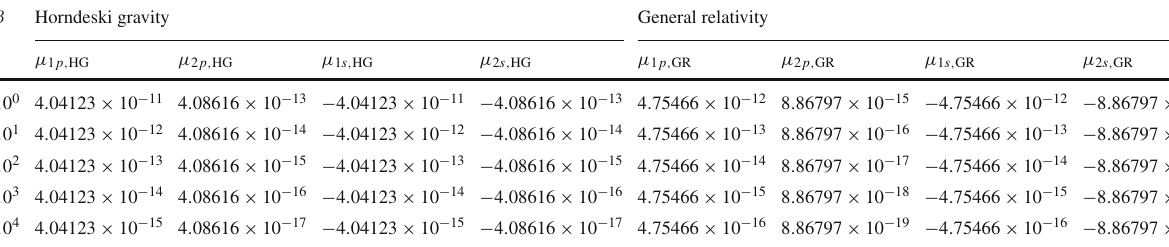
Table 7 Magnifications of first and second order relativistic images due to lensing by M87* with d = D LS / D OS = 0 . 5: GR and Horn- deski Gravity ( q = − 0 . 5 ) predictions for magnifications μ n is given for different values of angular source position β . (a) 1 p and 1 s refer to first order relativistic images on the same side as primary and sec-